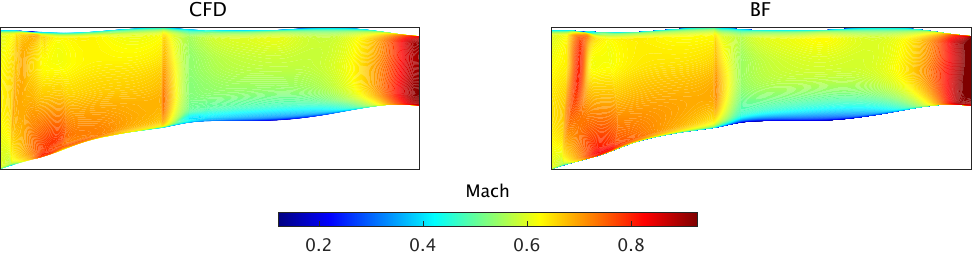
Figure 19. Mach number distribution for fan+OGV stage with CFD ( left ) and BF model ( right ).